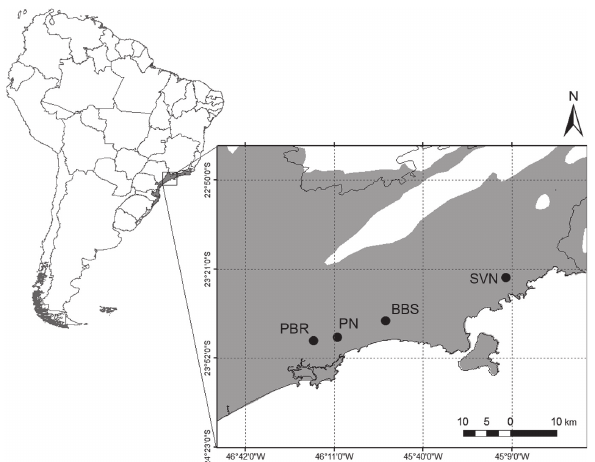
Figure 1. Location of the four protected areas in the Serra do Mar vegetation complex. The Serra do Mar ecoregion is indicated in gray. (BBS) Boracéia Biological Station, (PBR) Paranapiacaba Bio- logical Reserve, (PN) Parque das Neblinas, (SVN) Santa Virgínia